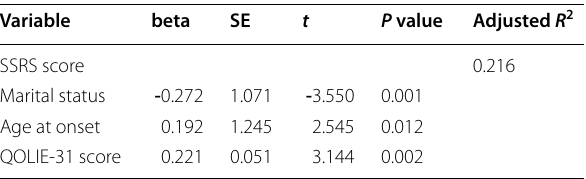
Table 3 Linear regression analysis of associated factors with the SSRS score